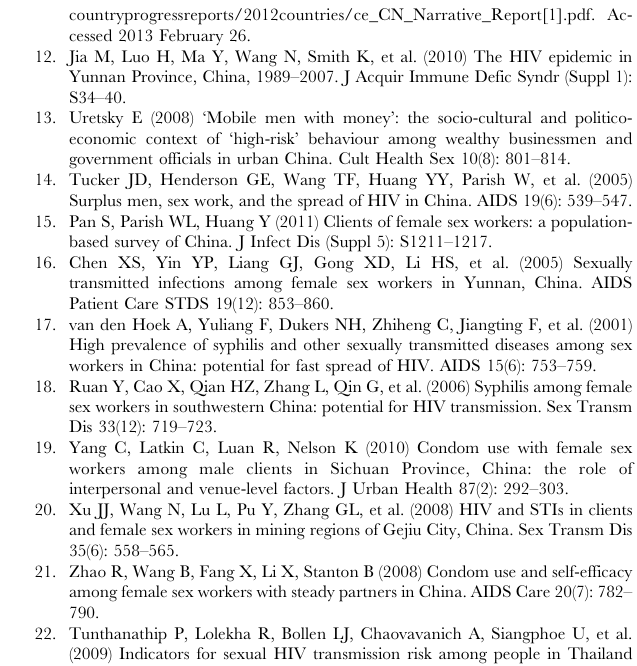
Table S1 PRISMA checklist for systematic reviews and meta-analyses. (PDF) Text S1 English and Chinese search terms used for the systematic review. (PDF) File S1 Forest plots for HIV, syphilis, gonorrhea, and chlamydia. Forest plots showing unadjusted estimates (squares) with 95% confidence intervals (bars) for HIV (Figure S1), syphilis (Figure S2), gonorrhea (Figure S3), and chlamydia (Figure S4) among male clients of female sex workers in China. The pooled prevalence estimate is represented as a red